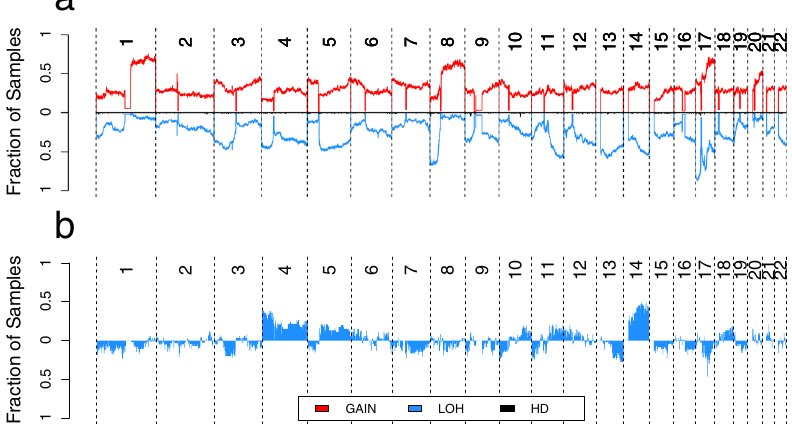
Fig. 5 Copy number landscape of Nigerian breast tumors. a Genome-wide landscape of gain, loss of heterozygosity (LOH), and homozygous deletion (HD) events in the Nigerian group. The y -axis represents fraction of tumors with a particular event. LOH and HD are shown in opposite direction for better visualization. b Differential landscape (Nigerian versus White) of LOH events in HER2 + tumors. Events in the positive direction are more frequent in the Nigerian group. 14q LOH was virtually exclusive to the Nigerian HER2 + subtype. Source data are provided as a Source Data fi